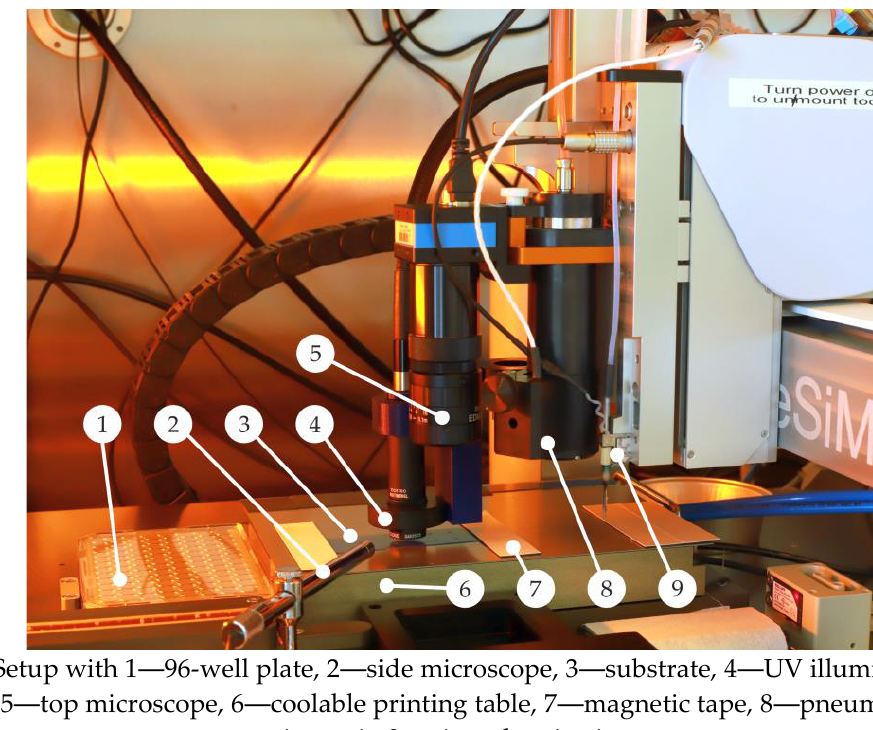
Figure 1. Printer setup under protective nitrogen atmosphere inside the glovebox; ( a ) process of inkjet printing of hydrogel prepolymer solution; ( b ) UV exposure of the prepolymer solution, ( c ) pneumatic extrusion of melted PEG for opening-valves and ( d ) an overview of all tools. The supporting video material (Videos S1 and S2) gives further insight.